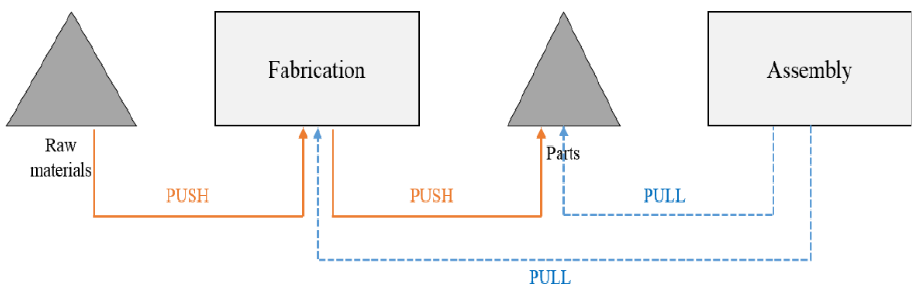
Figure 1. Reference example of hybrid Push/Pull production strategy in an assembly to order (ATO) environment.